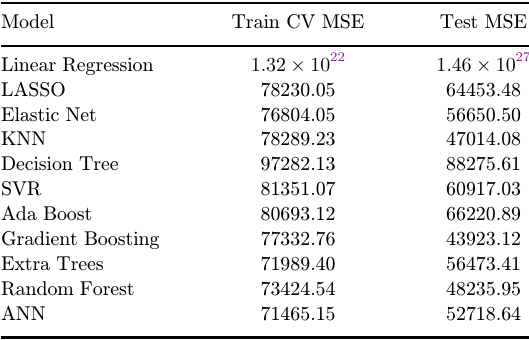
Table 4. Regression results of all machine learning models including neural networks using data-driven approach.